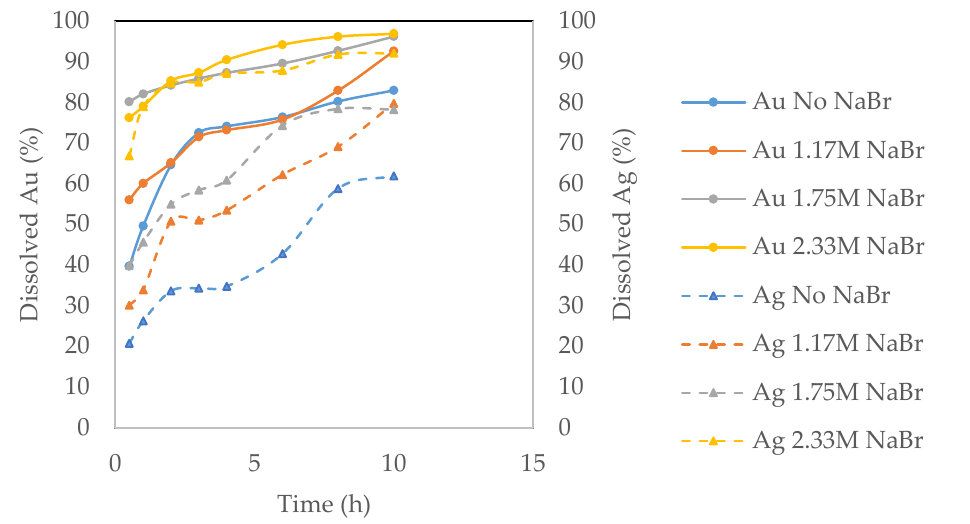
Figure 9. Dissolution of gold and silver at various concentrations of sodium bromide (0.78 M Br 2 , 23.5 °C and natural pH).